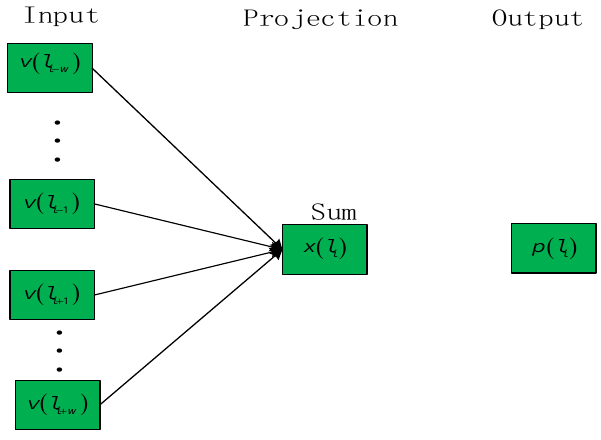
Figure 4. Calculation process the vectorization coding model.